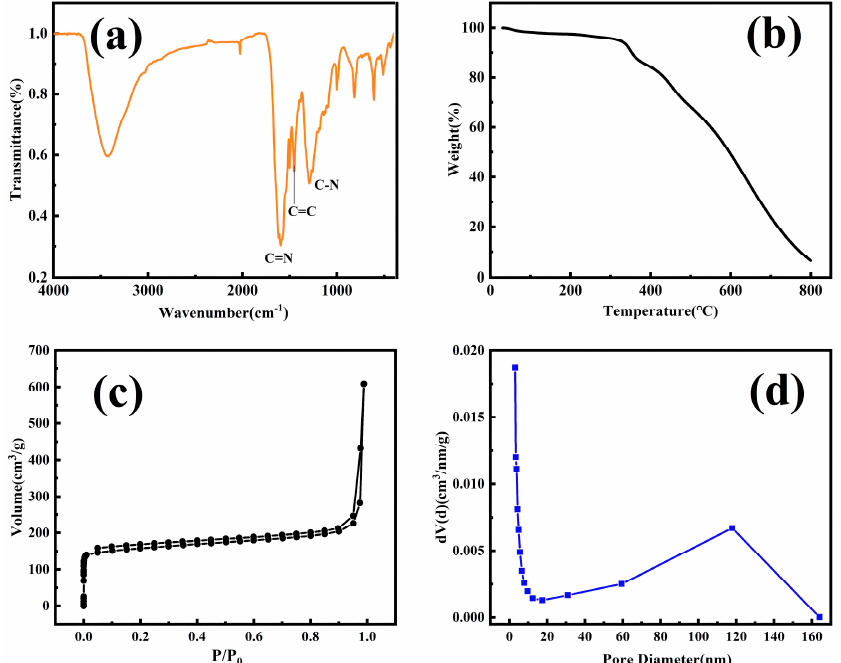
Figure 4. ( a ) FT-IR spectra of powder COF-TpBD; ( b ) TGA curve of powder COF-TpBD; ( c ) N 2 adsorption–desorption isotherms of the etched stainless steel sheet; ( d ) pore size distribution of the etched stainless steel sheet.